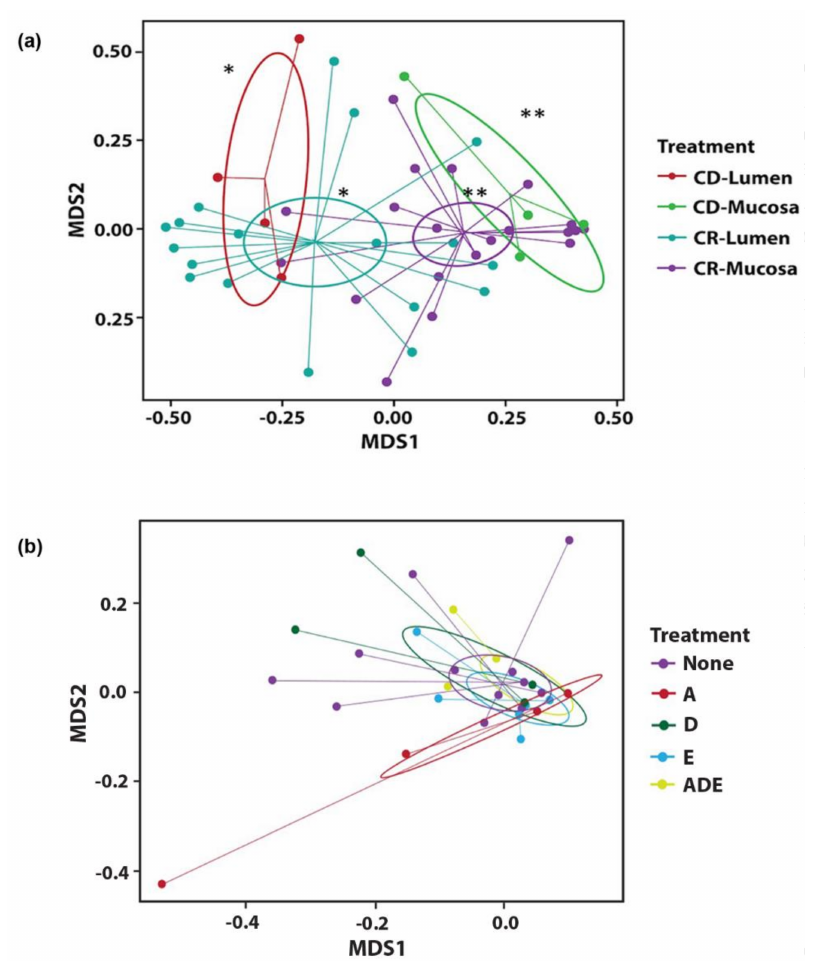
Figure 4. Non-metric multidimensional scaling (NMDS) was performed for each tissue and compared for each sample. NMDS ordination using a Bray–Curtis dissimilarity method was calculated to determine di ff erences in microbial community due to nutritional treatment. The NMDS plots with standard error ellipses were created using ‘ggplot2 (cid:48) . Beta-diversity indices measured within lumen contents and mucosa of the spiral colon in calves not fed colostrum, CD = colostrum deprived, and calves fed colostrum, CR = colostrum replacer ( a ). Di ff erent superscripts are statistically di ff erent, CD-Lumen versus CD-Mucosa, *,** p < 0.03; CR-Lumen versus CR-Mucosa, *,** p < 0.0002. Beta-diversity indices for overall e ff ects of supplementation with vitamins A, D, E, or a combined triad of ADE, measured within the ileum in calves ( b ). Samples were collapsed across lumen contents and mucosa within each treatment